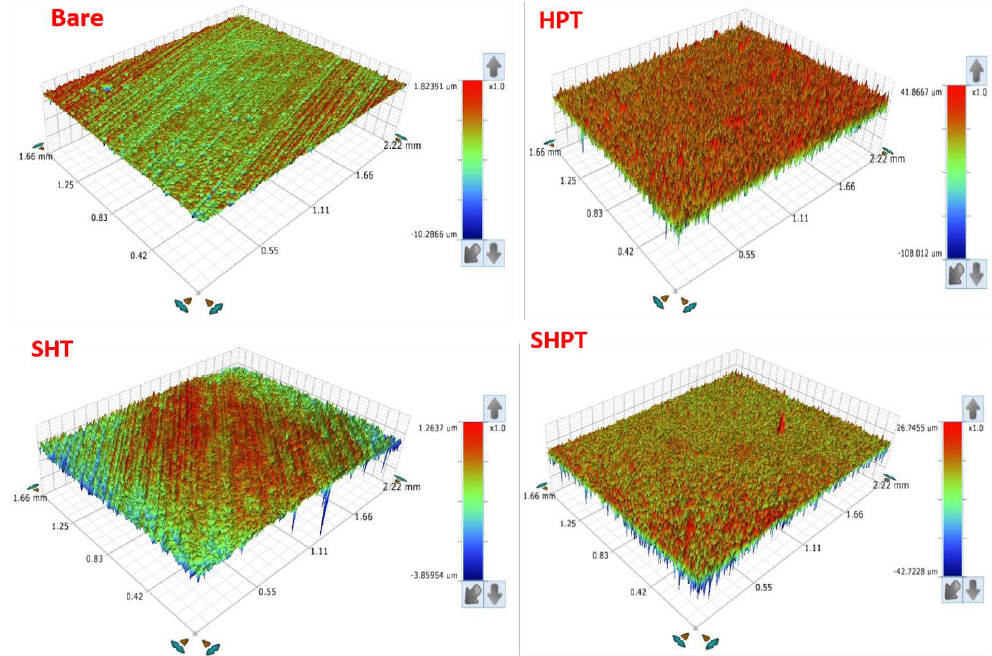
Figure 2. Surface topographic images of treated specimens.